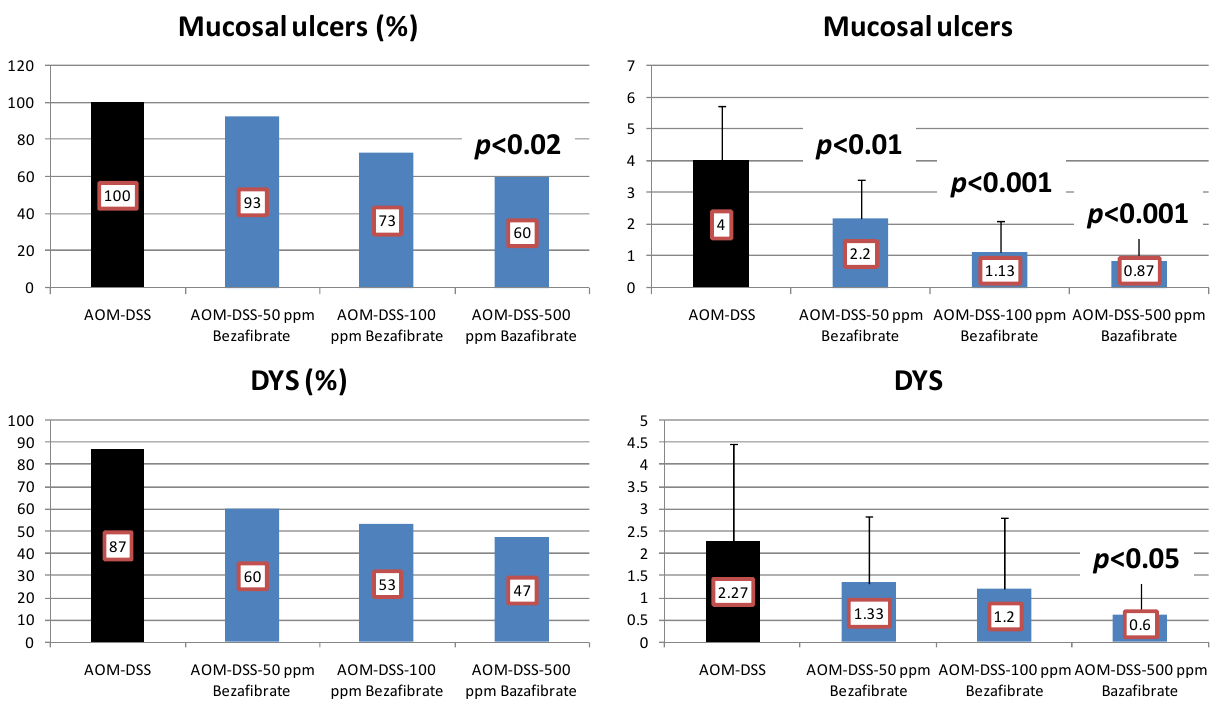
Figure 5. Incidences and multiplicities of mucosal ulcer and dysplastic crypts in the bezafibrate study.